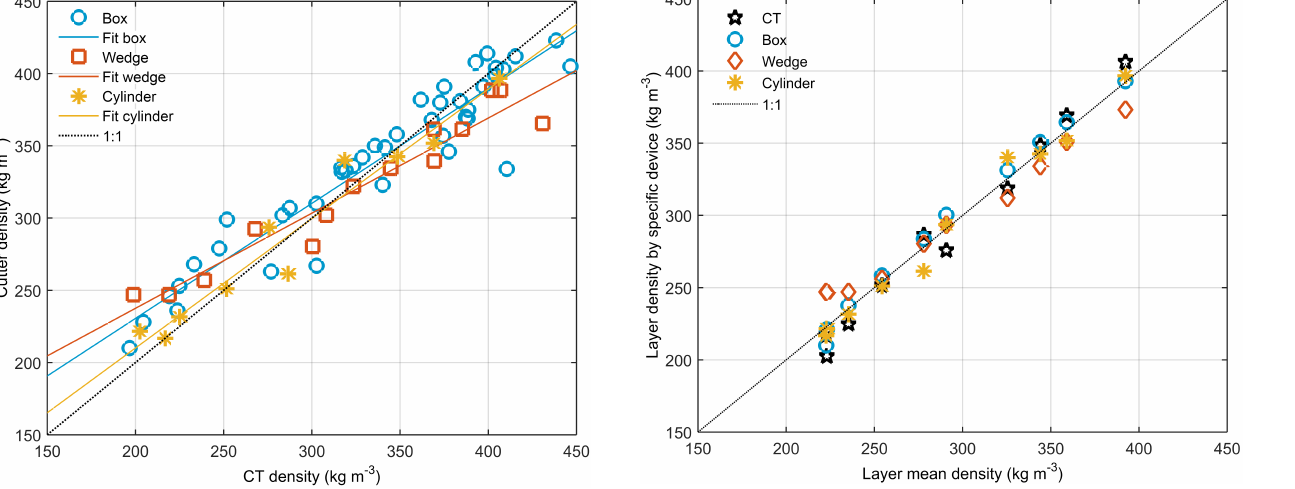
Figure 4. Cutter density vs. µ CT density averaged to the resolution of the cutters (symbols). In addition a linear fit for each comparison is shown (lines). Fit statistics are given in Table 5.